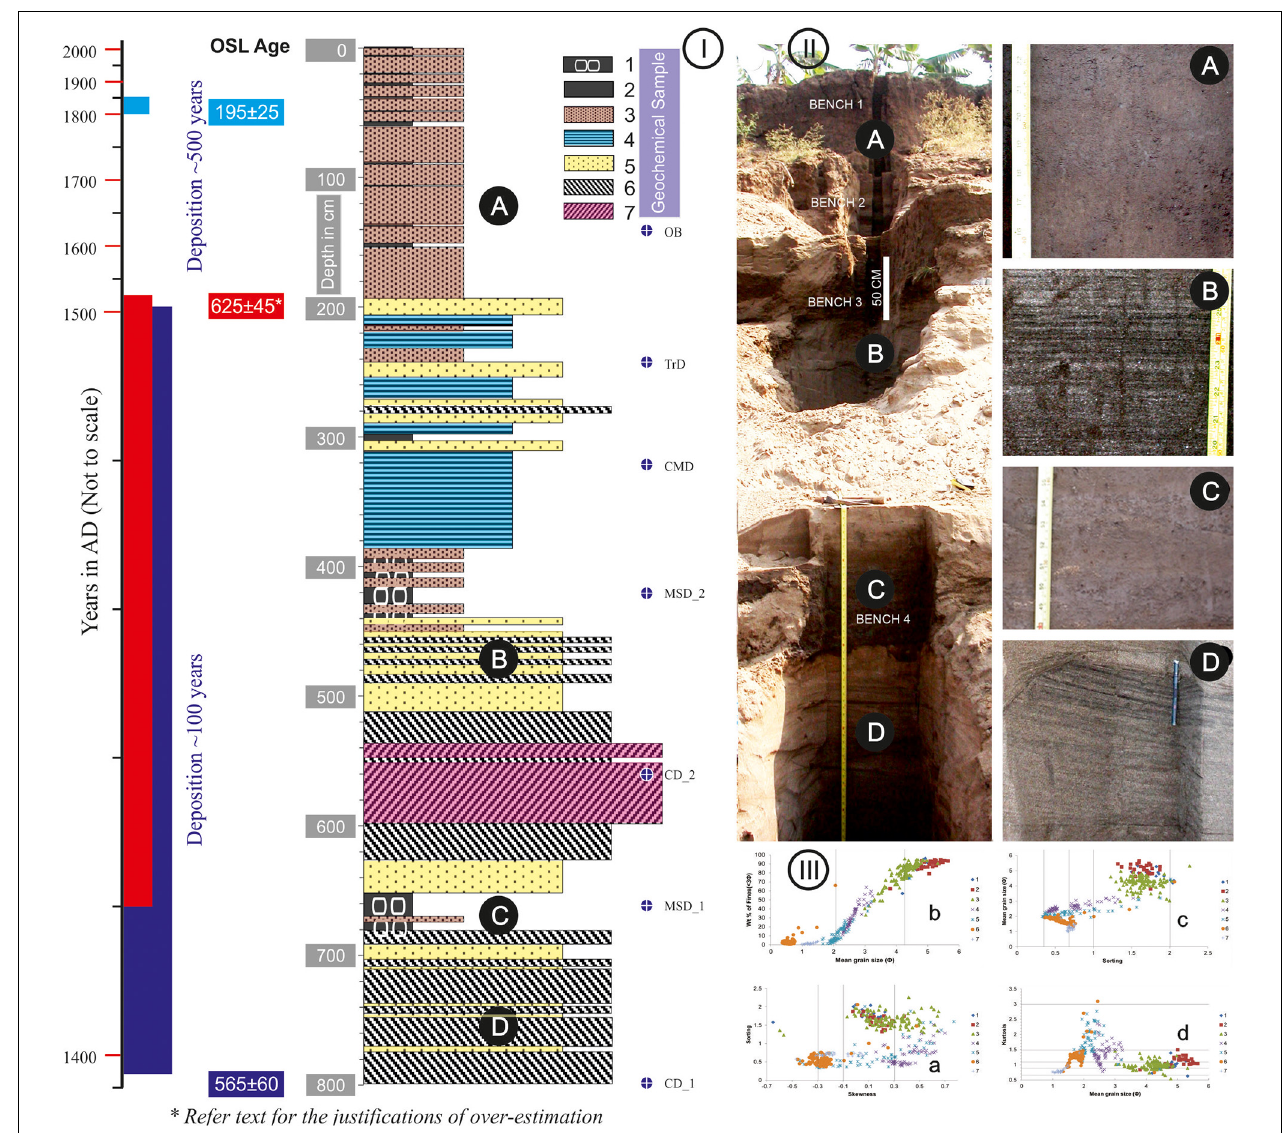
FIGURE 2 | Details of Uchediya sequence modified after Sukumaran et al. (2012b) summarising different characteristics of the Uchediya sequence (I) Change in sediment facies along depth profile (1, Fm SILT + VFS (T); 2, Fm SILT + VFS (O); 3, Fm SILT + VFS + FS ; 4, Sl FS + VFS ; 5, Sm FS + MS ; 6, St MS + FS + CS ; 7, St MS + CS ). CD-Channel deposit; MSD-monsoonal storms deposits; CMD-Channel margin deposits; TrD-Transition deposit; OB-Overbank deposits. (II) Filed photograph of a cut-open trench of the Uchediya sequence. (A–D) are photographs of different sub-facies. (III) Bivariate plots of different granulometric parameters.